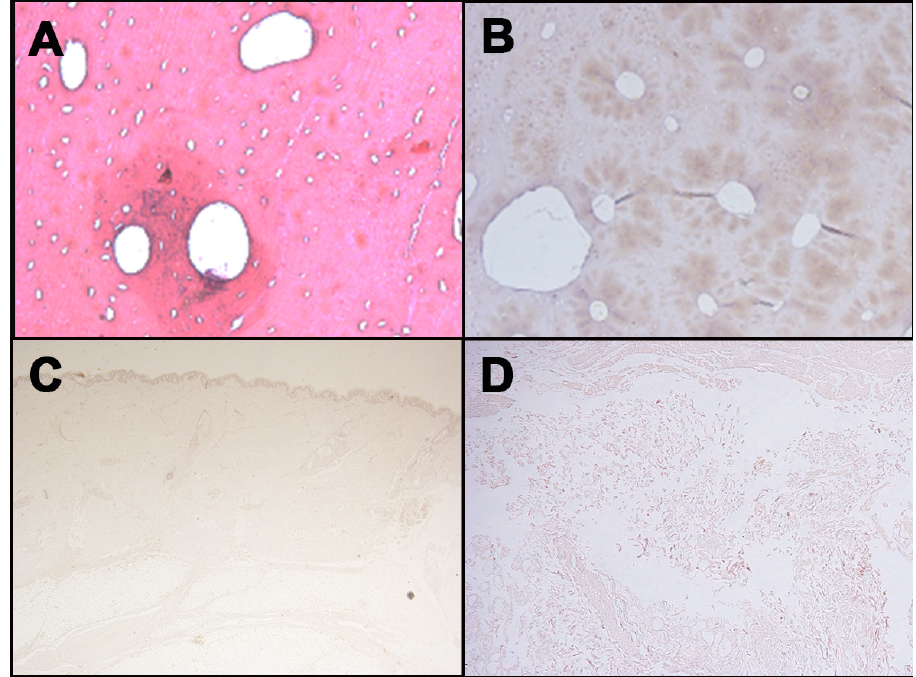
Figure 3. Negative immunohistochemical staining with anti-human GPA antibody for different tissues: Femur (( A ), H&E; ( B ), immunostaining with anti-human GPA antibody); ( C ) Skin; ( D ) Soft tissues surrounding laryngeal area.